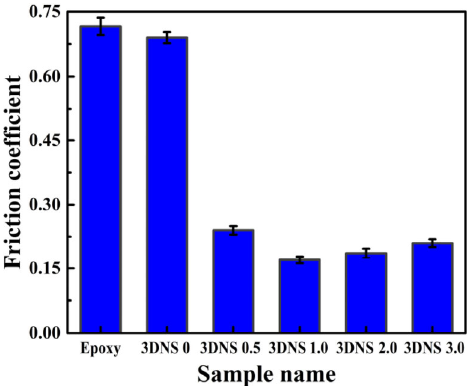
Fig. 7 Friction coefficients of epoxy resin and epoxy–Ti 3 C 2 3DNS composites.